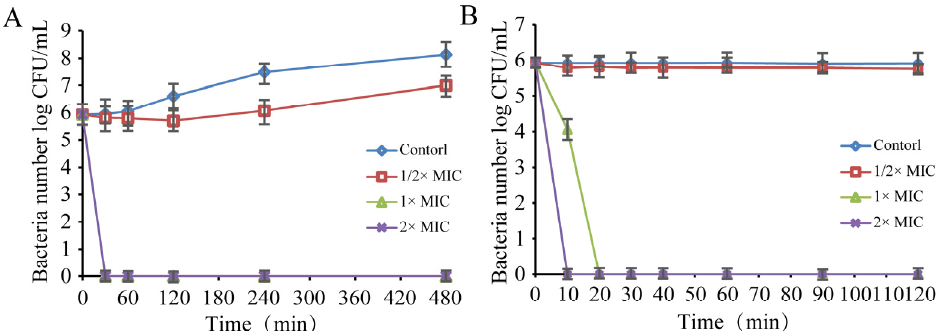
Figure 2. The effect of linalool on the number of S. sonnei in LB ( A ) and PBS ( B ) media at 37 °C. Bars represent the standard deviation ( n = 3).